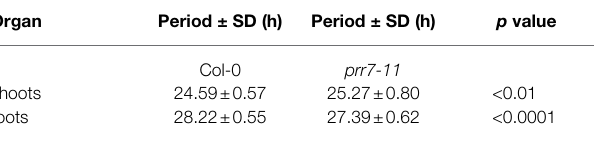
TABLE 2 | Differences in shoot and root periods between Col-0 and prr7-3.